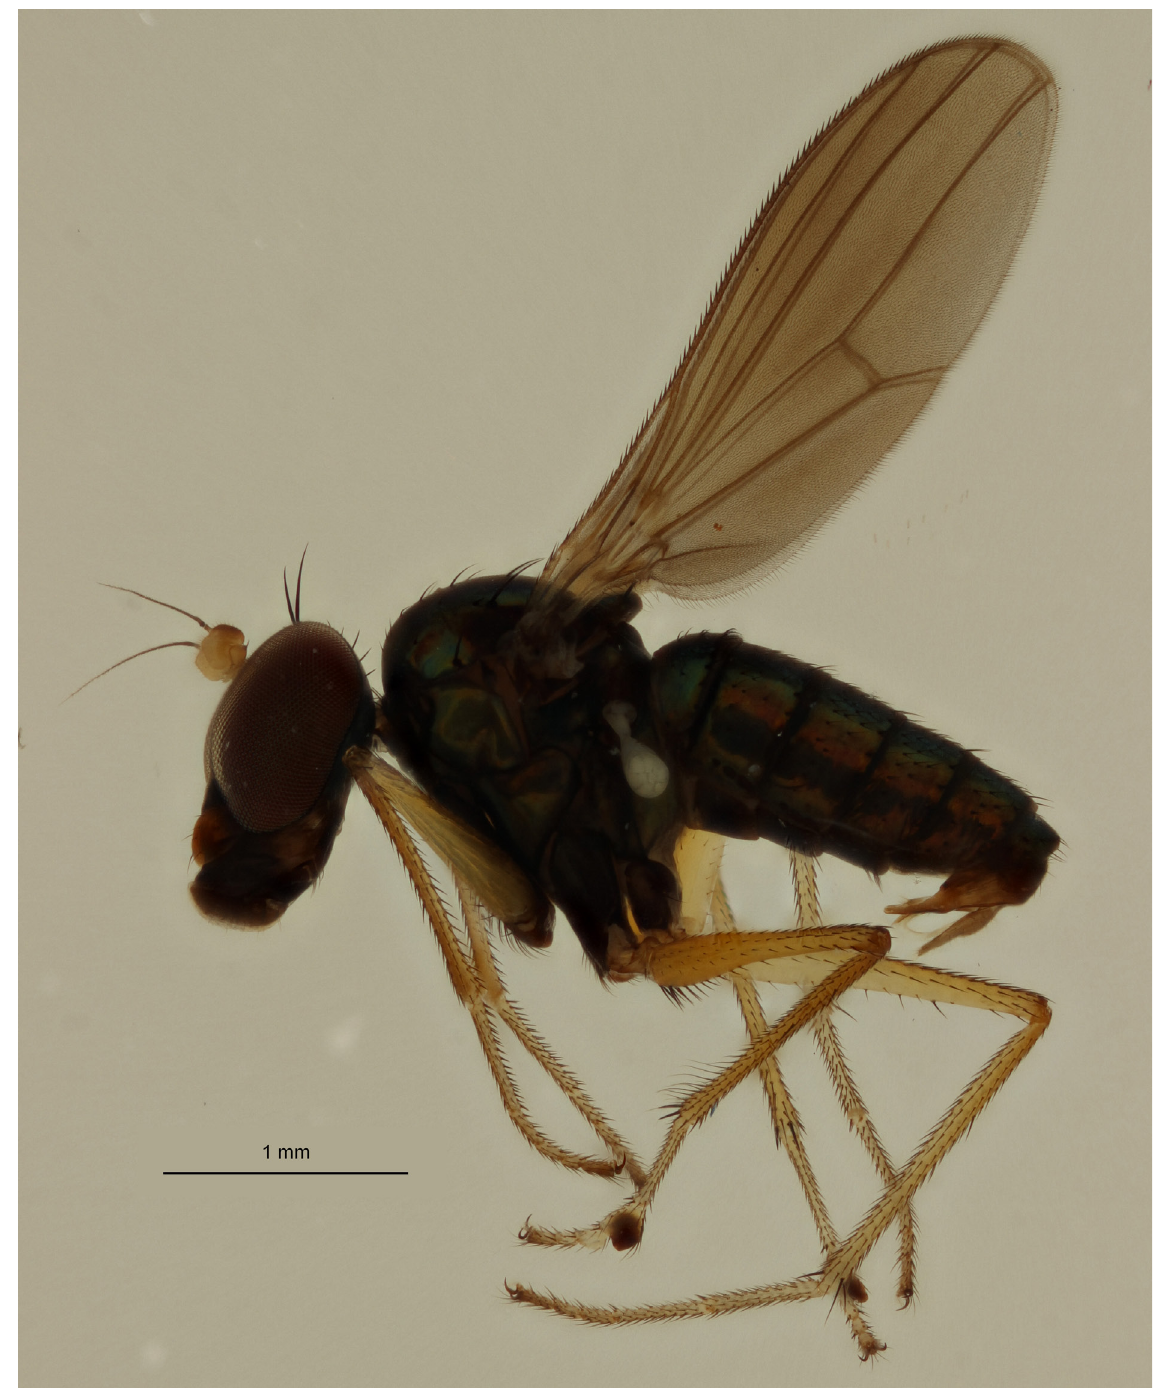
Fig. 16. Thinophilus parmatoides sp. nov., ♂,